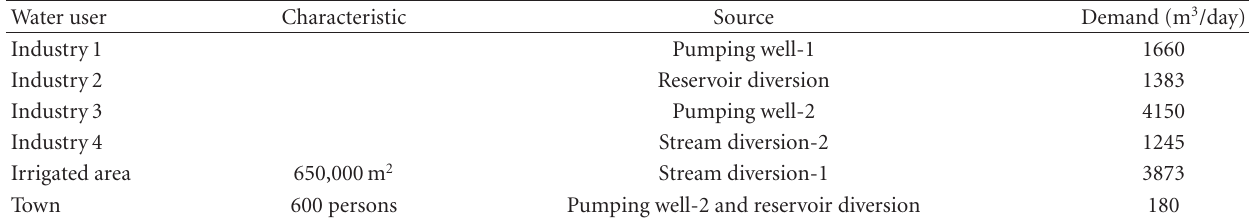
Table 2: Water demands in the study